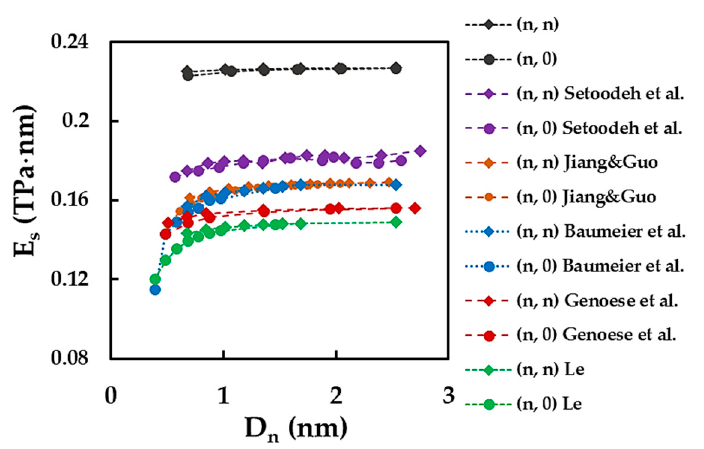
Figure 10. Comparison of the current results of the surface Young’s modulus of non-chiral SWSiCNTs with those reported in the literature [12,14,17,19,20], as a function of the NT diameter, D n . Table 3. Comparison of the surface Young’s modulus results obtained in the present study with those available in the